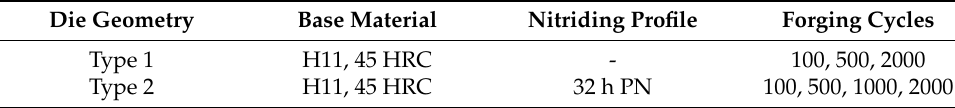
Table 5. Testing parameters for the laboratory forging tests.